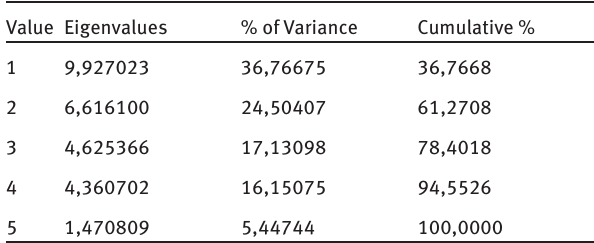
Table 3: The principal component analysis.